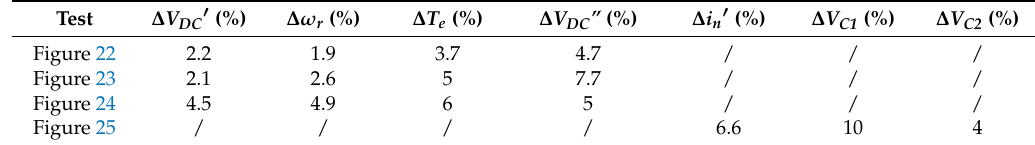
Table 7. Errors between experimental results and those obtained with the averaged-value